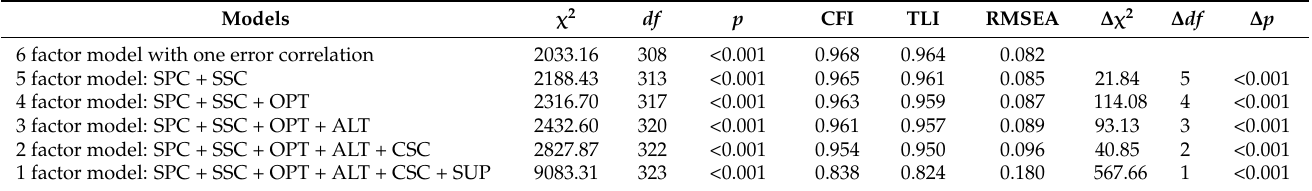
Table 4. Comparison of robust goodness-of-fit indices of configural invariance model in modified 6-factor model and combined 5-factor model.